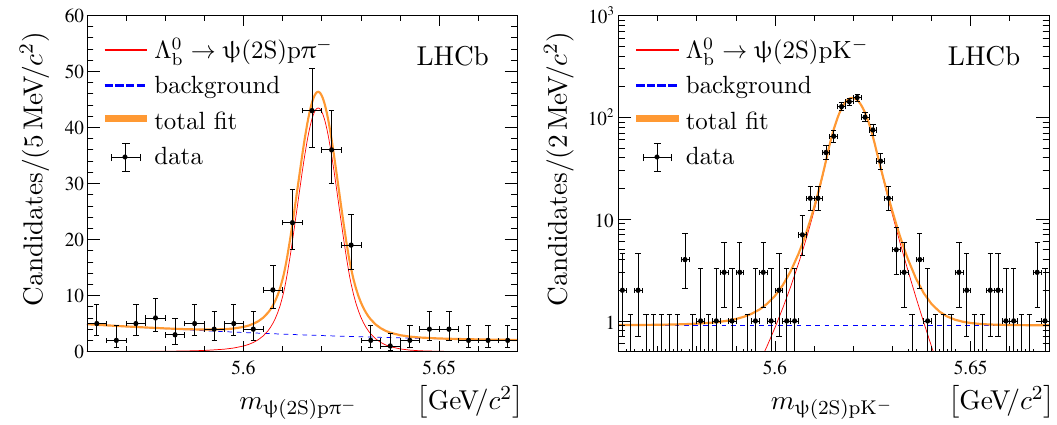
Figure 1 . Mass distributions of the (left) (cid:3) 0